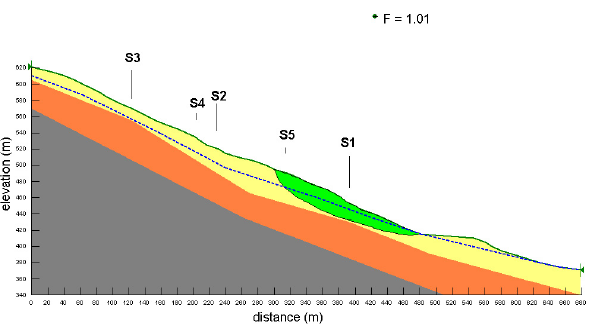
The refined criteria, proposed here, refer to a combination cf. Table 3) and maximum punctual velocities. It should be ent bodies (#1–6), the lowest must be considered for entering Table 2. The apparent incongruity between F i > 1 and v >